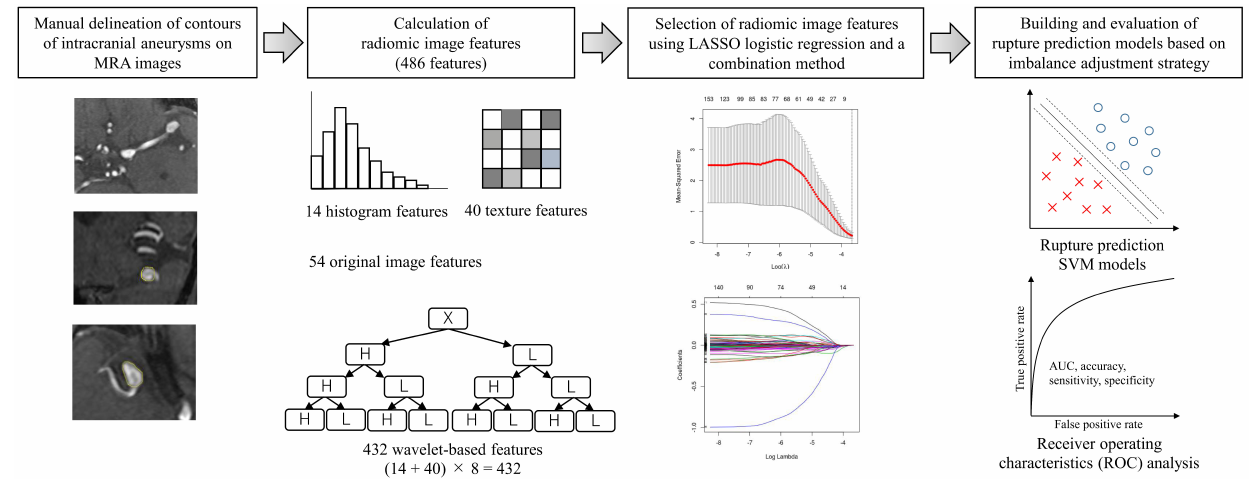
Figure 1. An overall workflow of a proposed model for prediction of degree of intracranial aneurysm rupture.